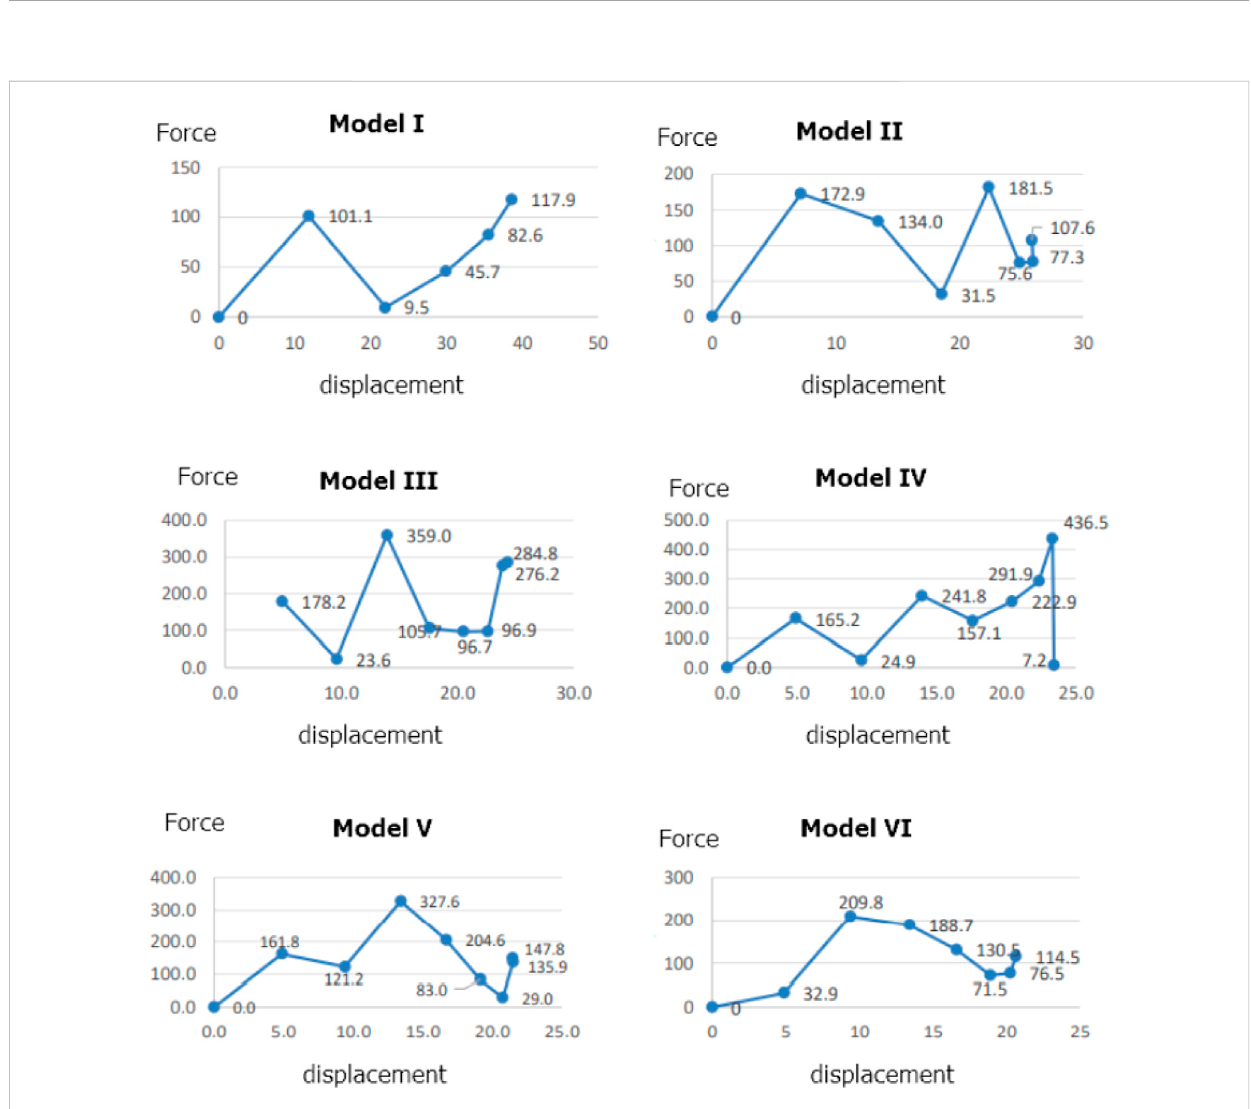
FIGURE 14 Force — displacement diagram of different structures under quasi static